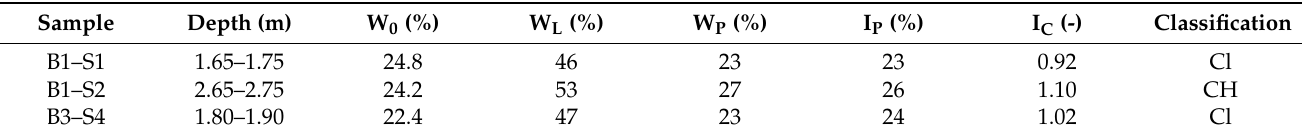
Table 2. Water content, Atterberg limits, and plasticity and consistency indexes with classification for three analysed